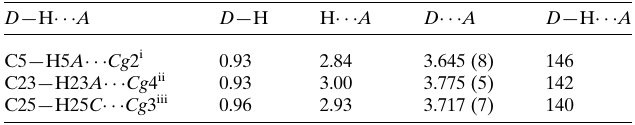
Table 1 Hydrogen-bond geometry (A˚ , (cid:3) ).